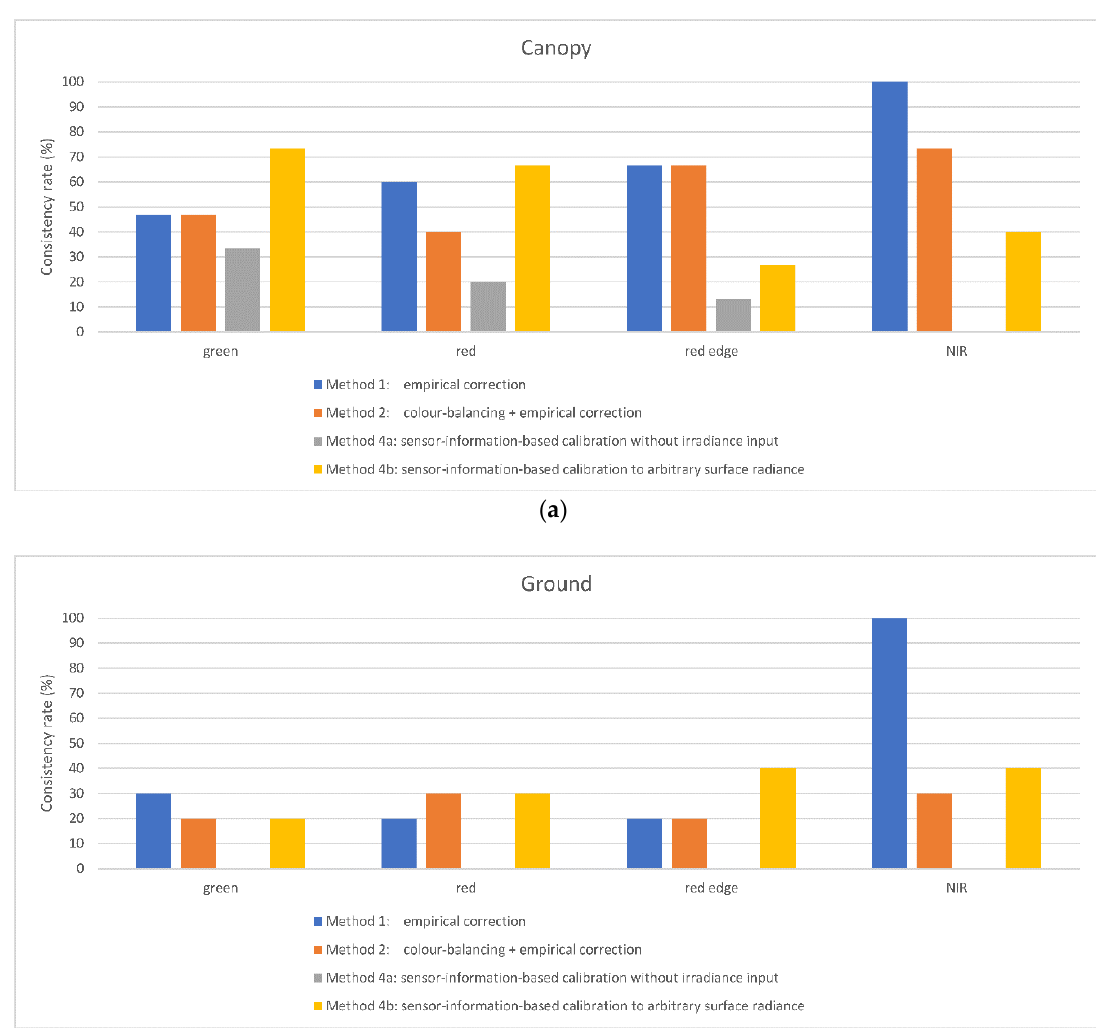
Figure 7. Consistency rate derived from box-and-whisker comparison for ( a ) canopy areas and ( b ) ground patches of banana datasets. The flight height is the same as avocado dataset 3 but the corrected values consistency is higher. The empirical-correction-based method provided higher consistency in red edge and NIR bands while sensor-information-based calibration provided higher consistency in green and red bands on canopies.